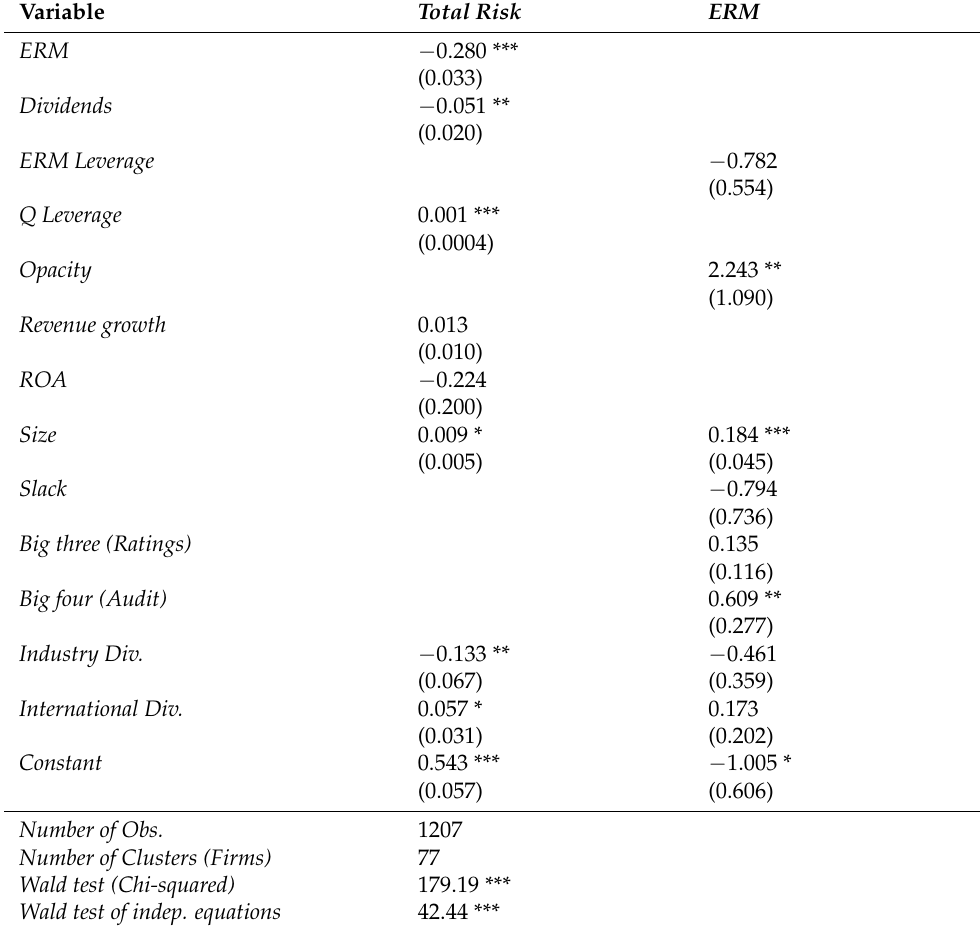
Table 6. Full maximum likelihood treatment effects model—Total